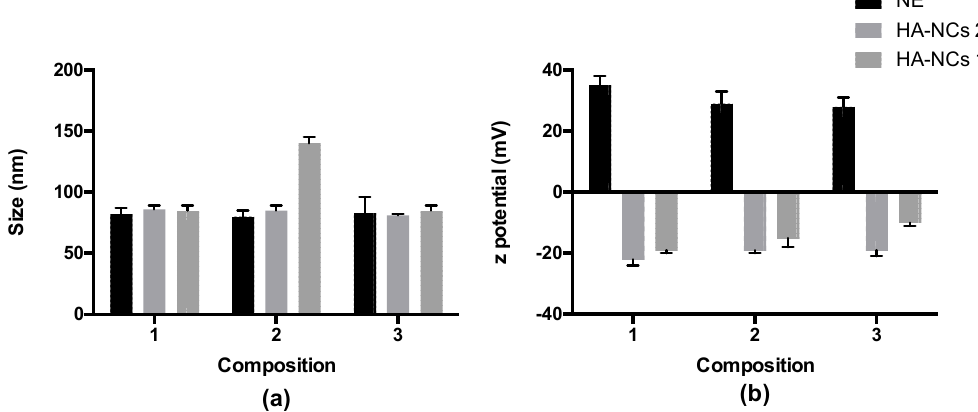
Figure 1. Physicochemical characterization of nanosystems according to their hydrodynamic diameter ( a ) and superficial charge ( b ). Composition 1: 50 mg LP-HCO and 60 mg TCPH; composition 2: 50 mg LP-HCO and 120 mg TCPH and composition 3: 100 mg LP-HCO and 60 mg TCPH. The amount of benzalkonium chloride was always constant (10 mg). NE: nanoemulsion, HA-NCs: hyaluronic acid nanocapsules (2S: two steps, 1S: 1 step). TCPH: α tocopherol and LP-HCO: Lipocol HCO-40.